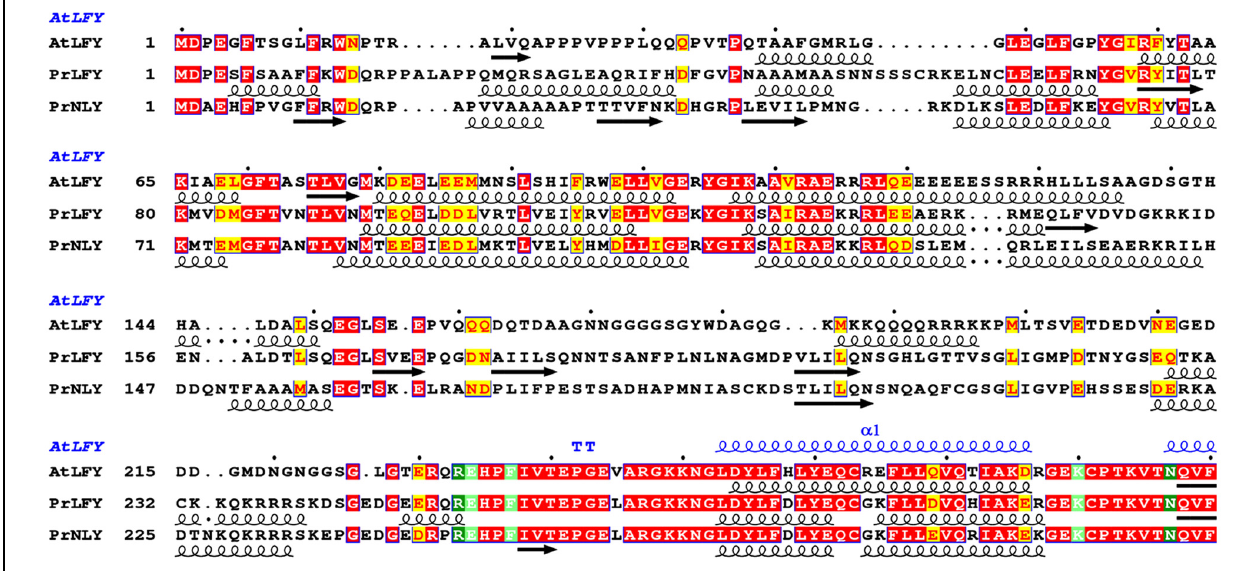
FIGURE 2 | Sequence alignment and secondary structure prediction of AtLFY, PrLFY, and PrNLY N-terminal domains, linker and start of conserved C-terminal DBD. Aligned amino acid sequences of AtLFY ( Arabidopsis thaliana LFY), PrLFY ( Pinus radiata LFY, PRFLL) and PrNLY ( Pinus radiata NLY), with respective secondary structure prediction indicated in black below each respective sequence; α -helices are represented by spirals and β -strands by arrows, all other regions are predicted to be unstructured. Sequence numbering is shown on the left and dots mark every 10th residue for the first sequence. Highly conserved regions are boxed, with similar residues represented in red against a yellow background, invariant residues represented against a red background and non-conserved residues indicated in black. Partial AtLFY DBD secondary structure, as derived from its X-ray structure (PDB 2VY1), is shown in blue above the sequences. Alignment was prepared with NPS@ (Combet et al.,